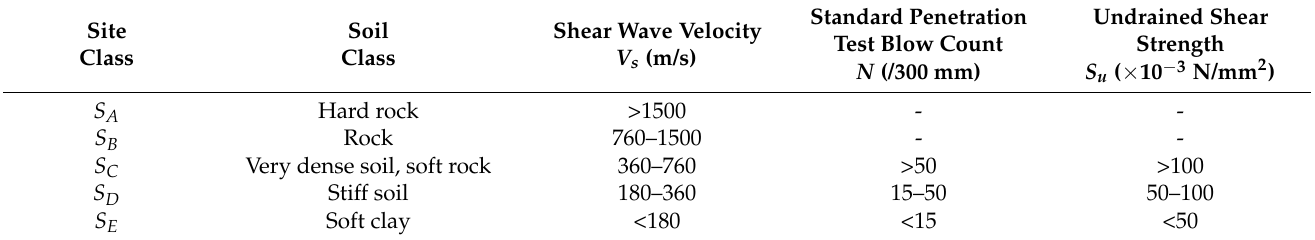
Table 4. Site classes in Korea.